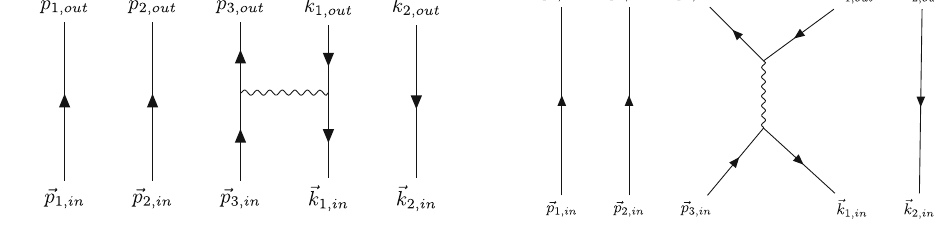
Fig. 4 Disconnected Feynman diagrams contributing to I 3 . On the left is the t-channel contribution and on the right the s-channel contribution